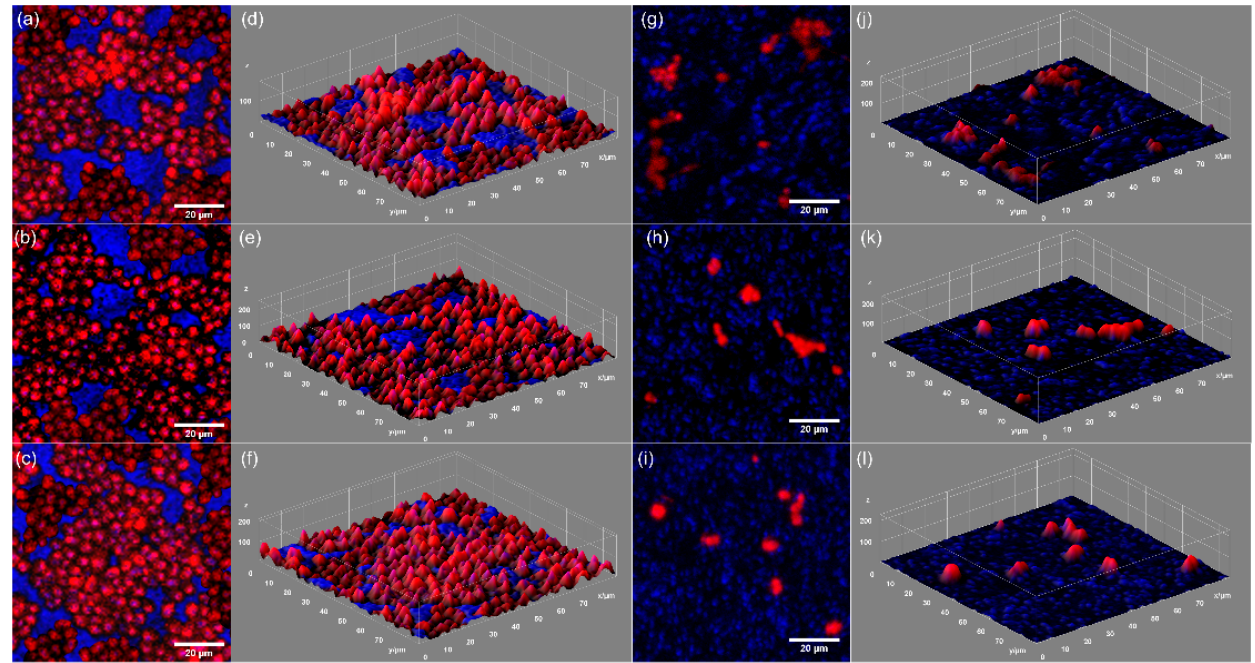
Figure 10. 2D images and 3D representations of the CLSM images of Candida albicans ATCC 10231 adhesion on HAp ( a − f ) and 5EuHAp ( g − l ) coatings deposited on Si after incubation for 24 h ( a , d , g , j ), 48 h ( b , e , h , k ), and 72 h ( c , f , i , l ).